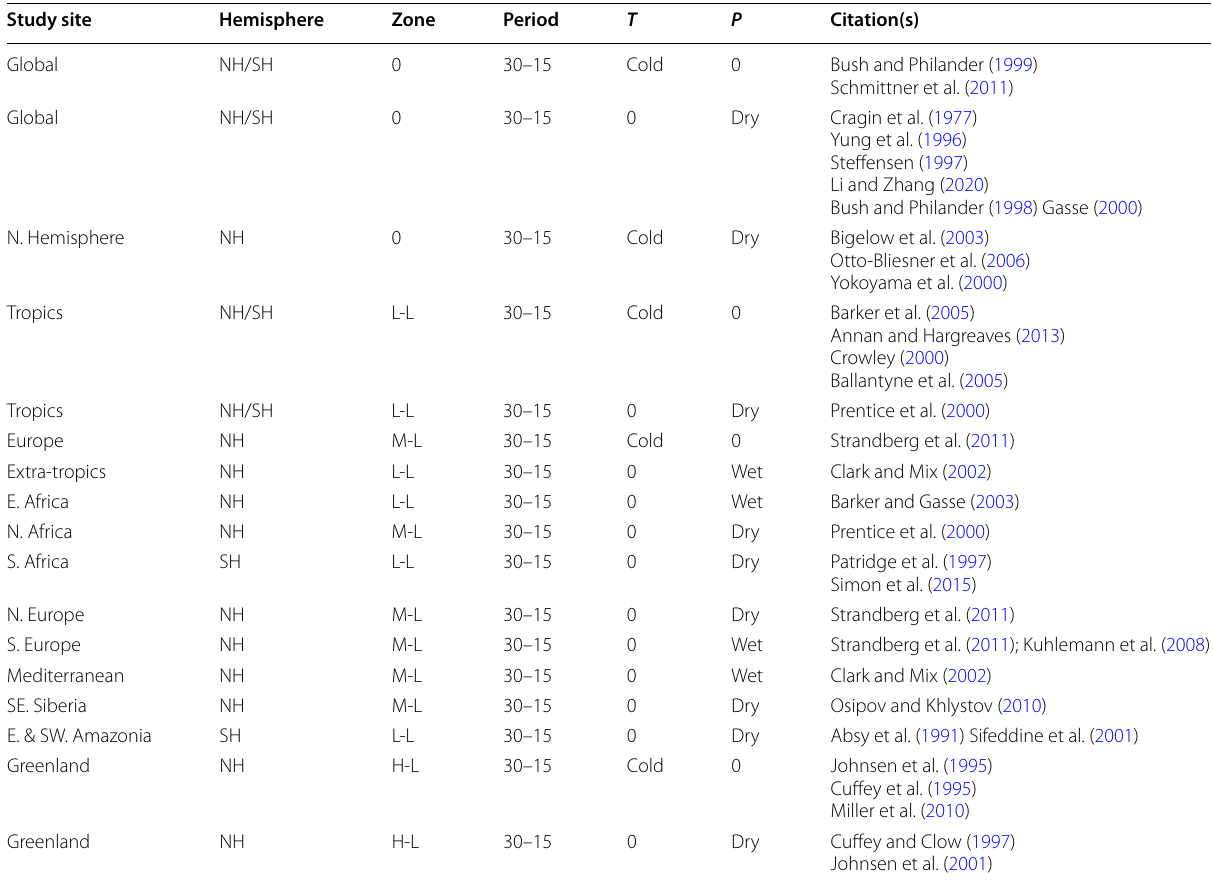
Table 3 Temperature and precipitation conditions during the